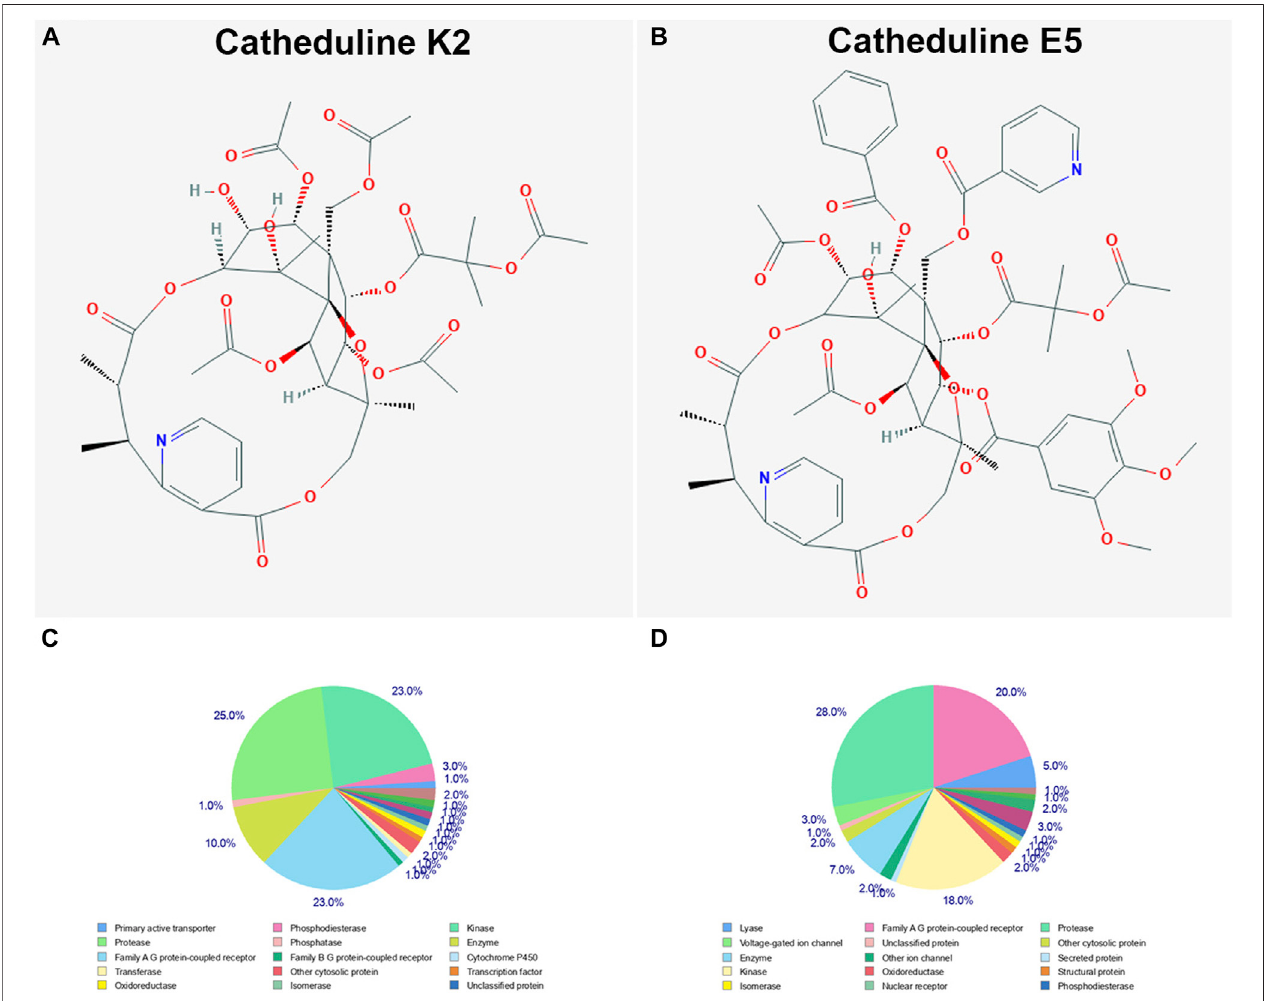
FIGURE8| SwissTargetPredictionanalysisoftwomembersofthecathedulinskhatconstituents,cathedulineK2 (A) (PubChemCID101290208),andcatheduline E5 (B) (PubChem CID 124201484) showing top 100 targets for both components (C, D), respectively. Both cathedulins have the potential to highly bind with the protease, kinase, and Family A G protein-coupled receptor in addition to other potential targets.